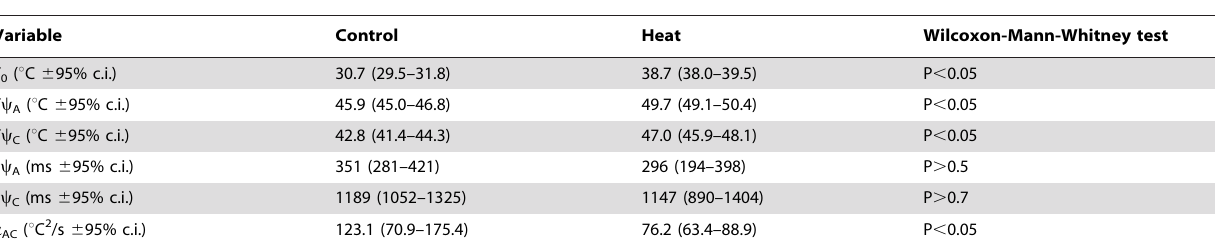
Table 4. Effects on the psychophysical variables of heating the